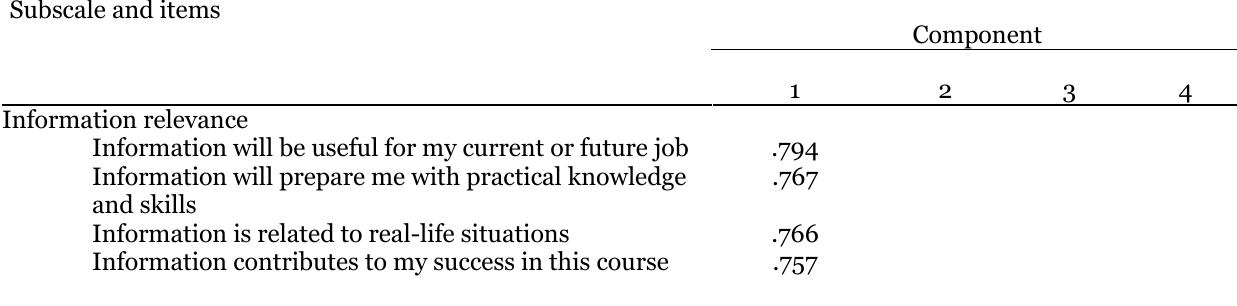
Summary of Exploratory Factor Analysis Results for the OCOI (n = 378) Subscale and